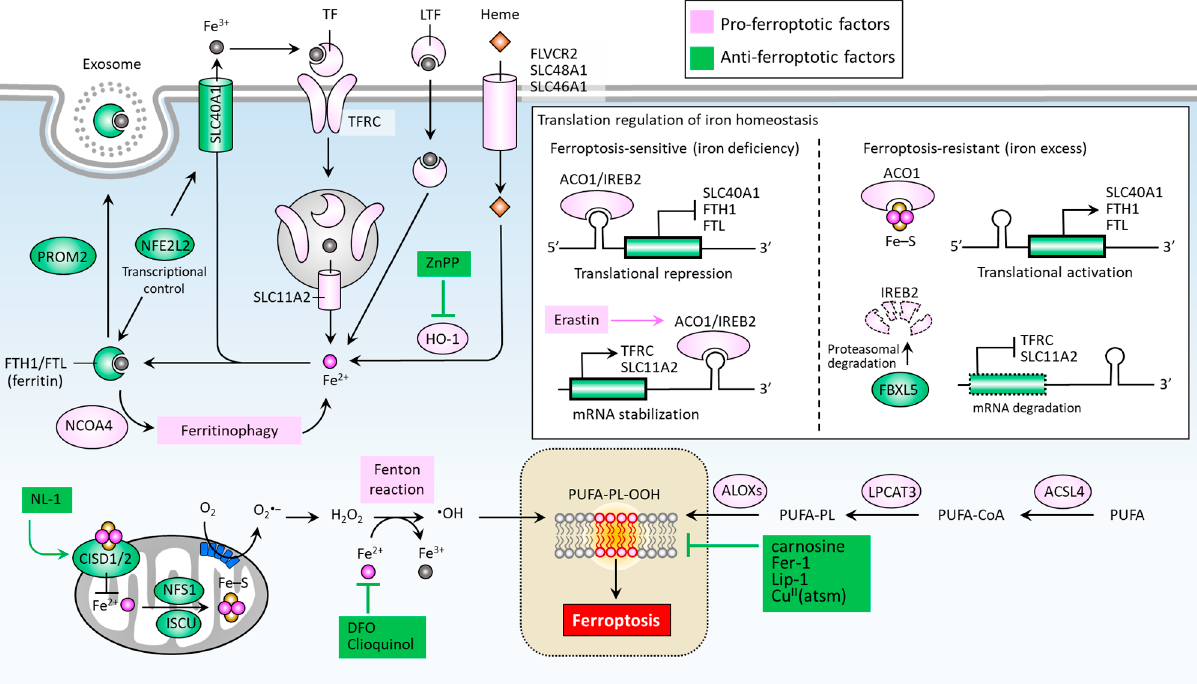
Figure 2. Molecular pathways of iron metabolism and lipid peroxidation in ferroptosis. Ferroptosis is mainly activated by iron accumulation-mediated lipid peroxidation, which is determined by key factors accounting for the import, export, and metabolism of iron and the formation of lipid peroxides (PUFA-PL-OOH). ∙ OH, hydroxyl radical; ACO1, aconitase 1; ACSL, acyl-CoA synthetase long chain family members; ALOXs, lipoxygenases; CISD1/2, CDGSH iron sulfur domain 1/2; Cu II (atsm), diacetyl-bis(4-methyl-3-thiosemicarbazonato) copper II ; DFO, desferoxamine; FBXL5, F-box and leucine-rich repeat protein 5; FTH1, ferritin heavy chain 1; FTL, ferritin light chain; H 2 O 2 , hydrogen peroxide; HO-1, heme oxygenase-1; IREB2, iron response element binding protein 2; ISCU, iron-sulfur cluster assembly enzyme; LPCAT3, lysophospholipid acyl-transferase 3; LTF, lactotransferrin; NCOA4, nuclear receptor co-activator 4; NFE2L2, nuclear factor erythroid 2 like 2; NFS1, NFS1 cysteine desulfurase; PROM2, prominin 2; PUFA-PL-OOH, lipid peroxides generated from polyunsaturated fatty acid-containing phospholipids; SLC11A2, solute carrier family 11 member 2; SLC40A1, solute carrier family 40 member 1; SCL46A1, solute carrier family 46 member 1; SCL48A1, solute carrier family 48 member 1; TF, transferrin; TFRC, transferrin receptor.